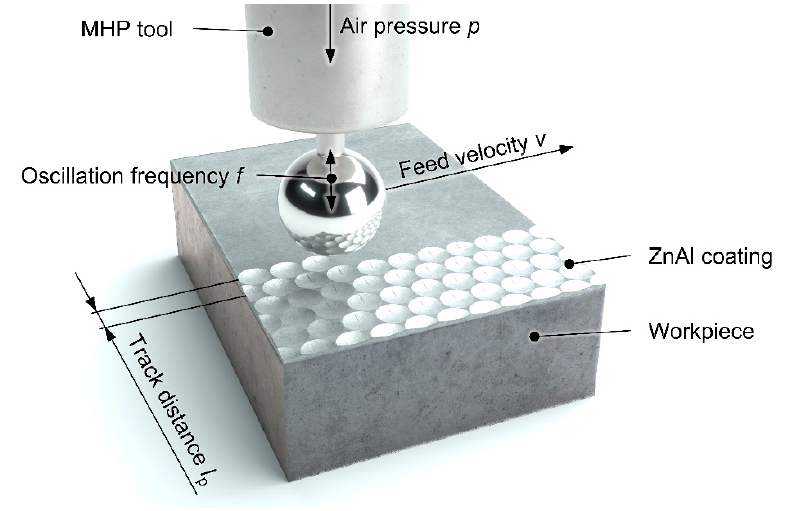
Figure 1. Principle of the MHP process.